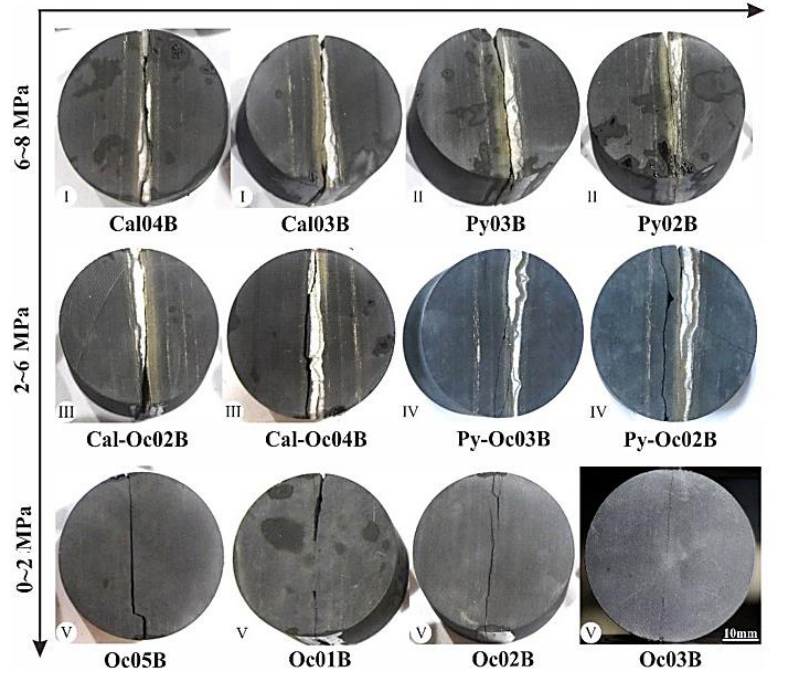
Figure 8. Failure morphology of shale with different laminae crossing the center of Brazilian discs. Table 3. Tensile strength levels and fracture morphology features of shale with various central mineral interlayers.